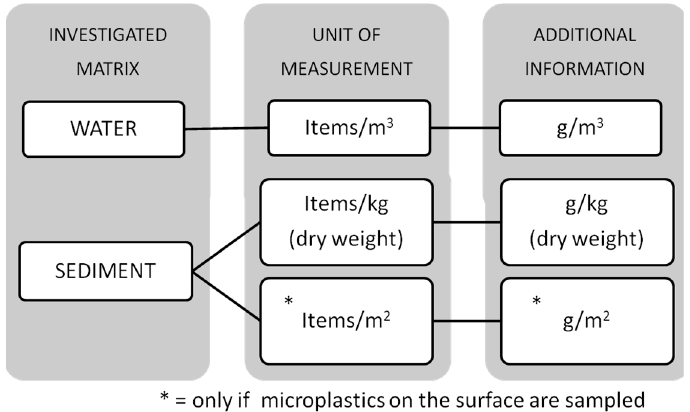
Figure 10. Suggested units of measurement to express the results in the articles on microplastics detected in environment matrices.